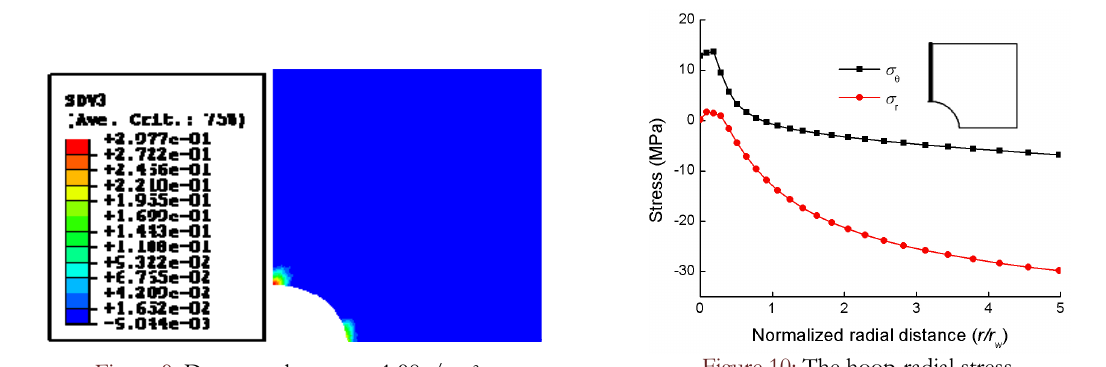
 =1.98g/cm 3 . Figure 10: The hoop-radial stress. Figure 9: Damage when m